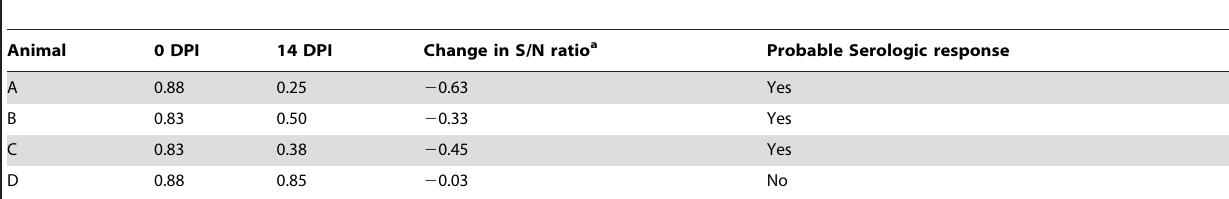
Table 2. Antibody assessments in raccoons experimentally infected with an avian influenza virus through contact with virus-laden water (high dose treatment).